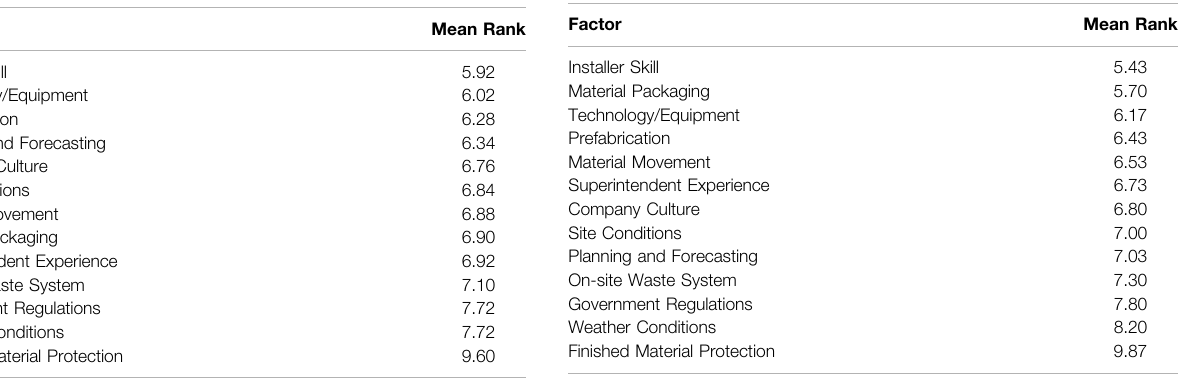
TABLE 6 | Mean ranks of the factors considering all participants ’ responses.